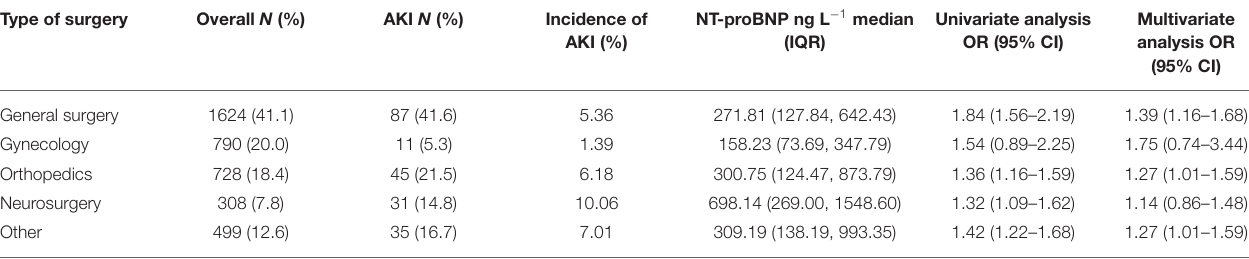
TABLE 2 | The relationship between pre-operative NT-proBNP measurement and development of AKI in different types of surgery. Type of surgery